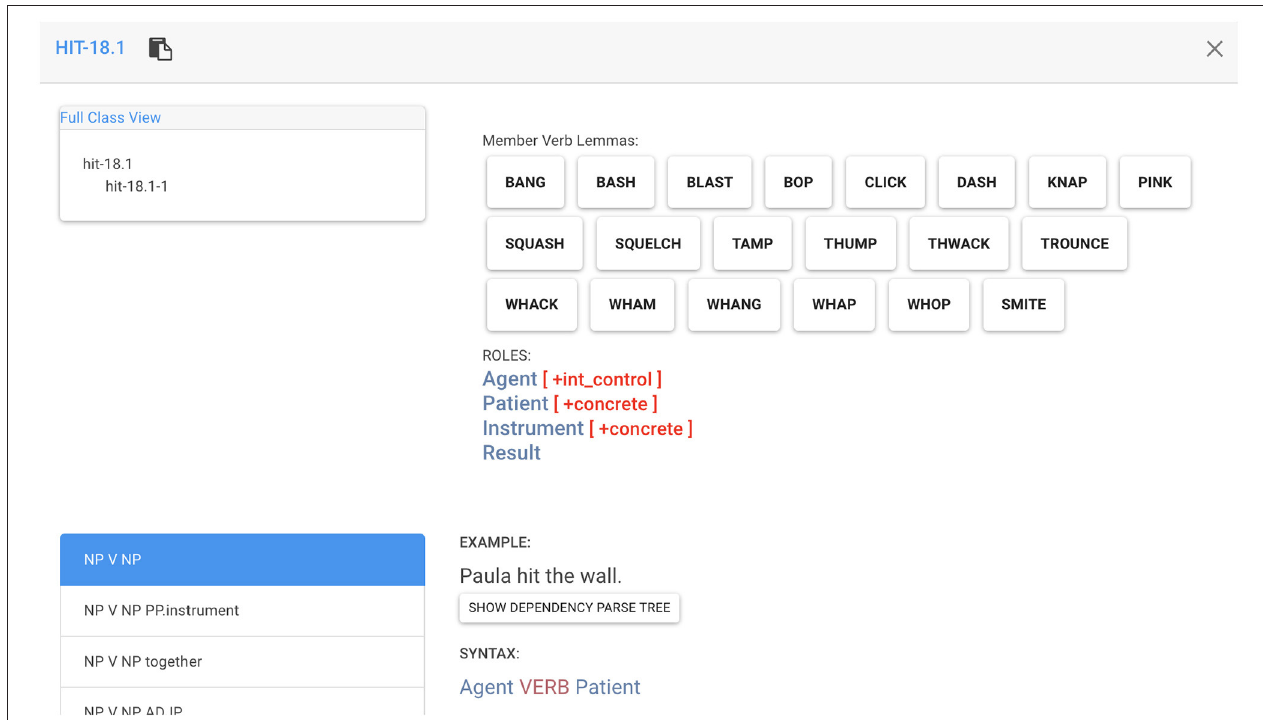
FIGURE 2 | A screenshot of the VN Hit-18.1 class. For a complete interactive view, see